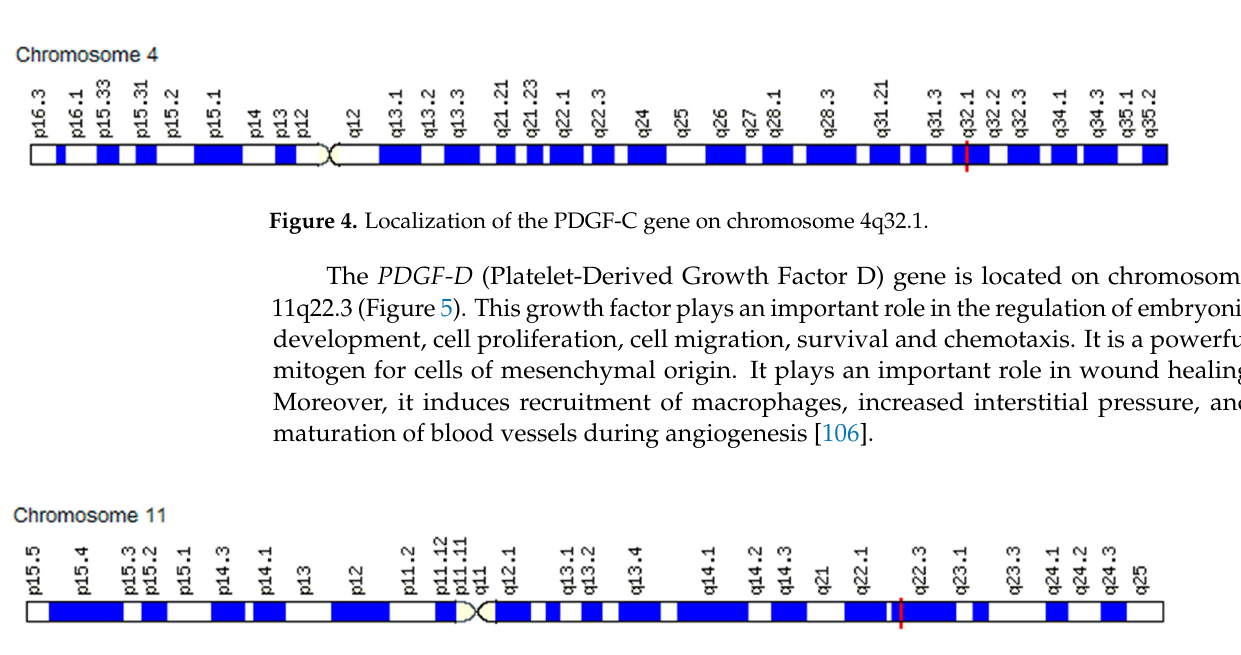
Figure 3. Localization of the PDGF-B gene on chromosome 22p13.1.